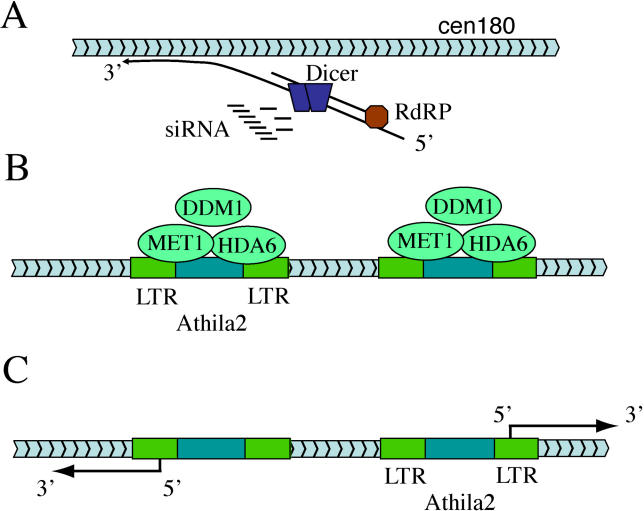
A Model for the Regulation and Evolution of Centromeric Satellite Repeat Transcripts(A) New tandemly arranged repeats are transcribed on one strand and processed by RNAi.(B) Older repeats accumulate retrotransposon insertions that interrupt and silence the transcripts via MET1, HDA6, and DDM1.(C) In met1, hda6, or ddm1 mutants, the silencing complex is lost and promoters from retrotransposon LTRs drive transcription from both strands. cen180 repeats are blue chevrons, and retrotransposons are green boxes (not to scale).